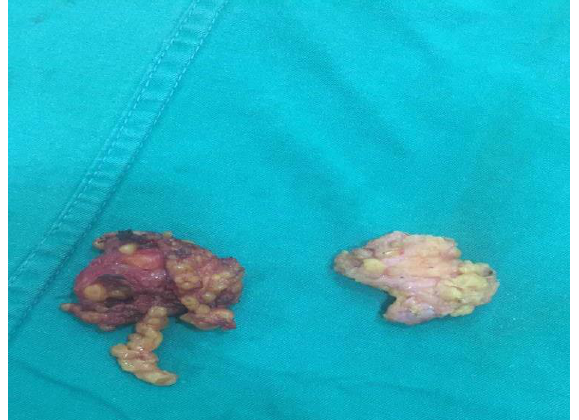
Figure (3) Fibro glandular breast tissue